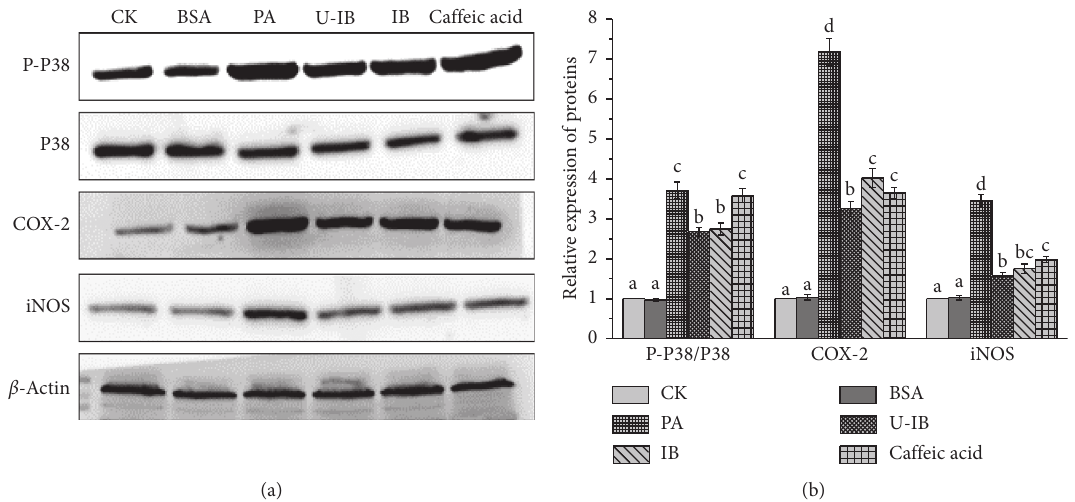
Figure 5: Effects of insoluble-bound fraction and caffeic acid on the protein expression levels of P38, COX-2, and iNOS (a) and the relative protein expression levels (b). Protein expression levels were normalized with β -actin, according to grayscale. Data are expressed as mean ± SD ( n � 3). In Figure 5(b), mean values with different letters are significantly different ( p < 0 . 05). CK: control group; BSA: BSA/ NaOH complex solution; PA, PA/BSA complex solution; P38, P38 mitogen activated protein kinases; COX-2: cyclooxygenase-2; iNOS: inducible nitric oxide synthase; IB: insoluble-bound phenolic fraction; U-IB: UHP-treated insoluble-bound phenolic fraction.